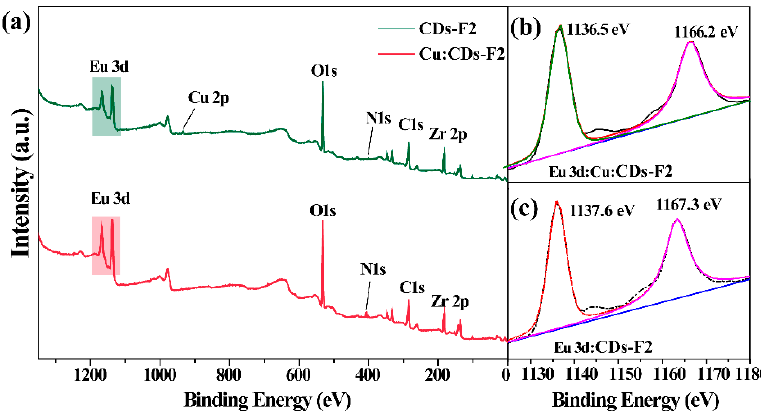
Figure 6. ( a ) XPS spectra of CDs-F2 and Cu: CDs-F2. The binding energy of Eu 3d in Cu: CDs-F2 ( b ) and CDs-F2 ( c ).